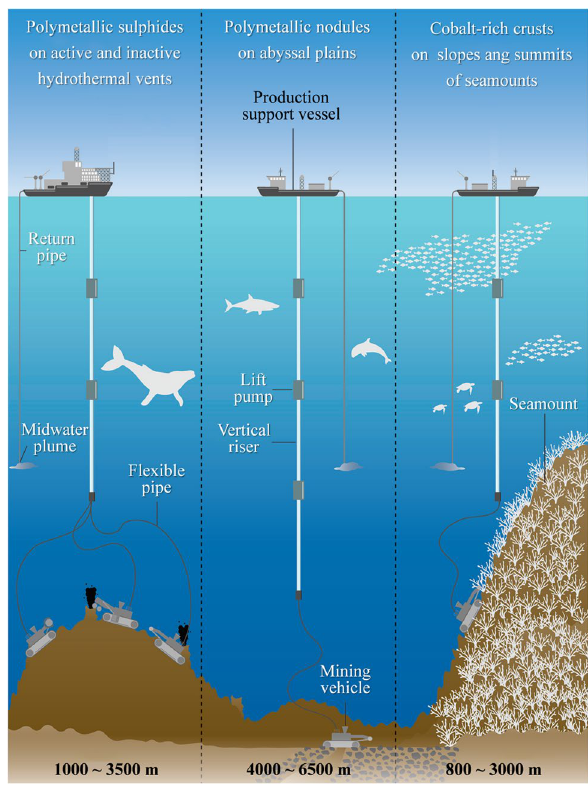
Fig. 21 Schematic diagram of the seabed mining process and its interaction with the ecological environment for the three main deposit types (modified from Miller et al. 2018)